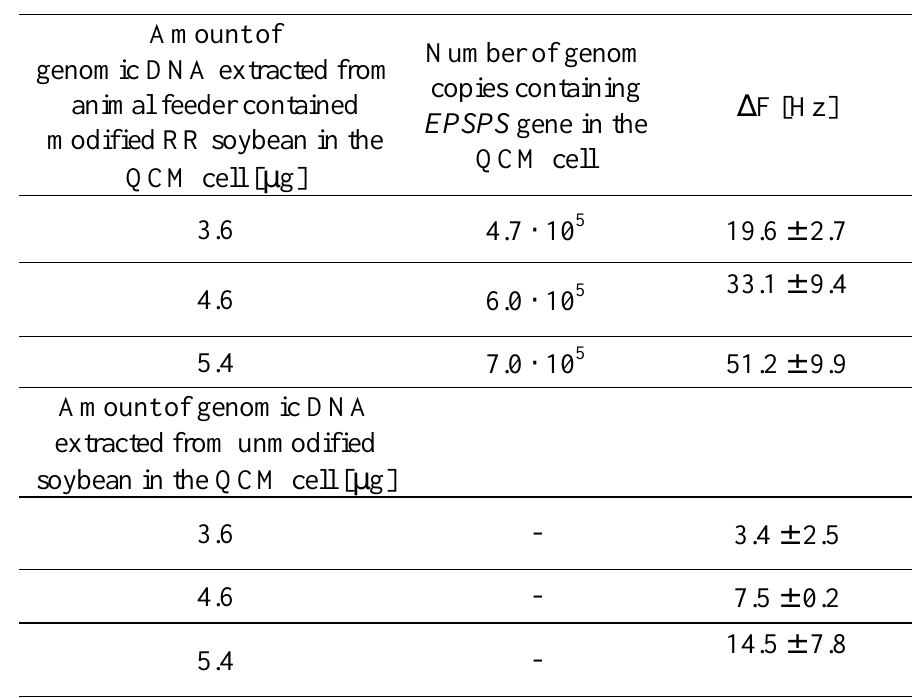
Table 3. Determination of the EPSPS gene in non-amplified by PCR genomic DNA samples